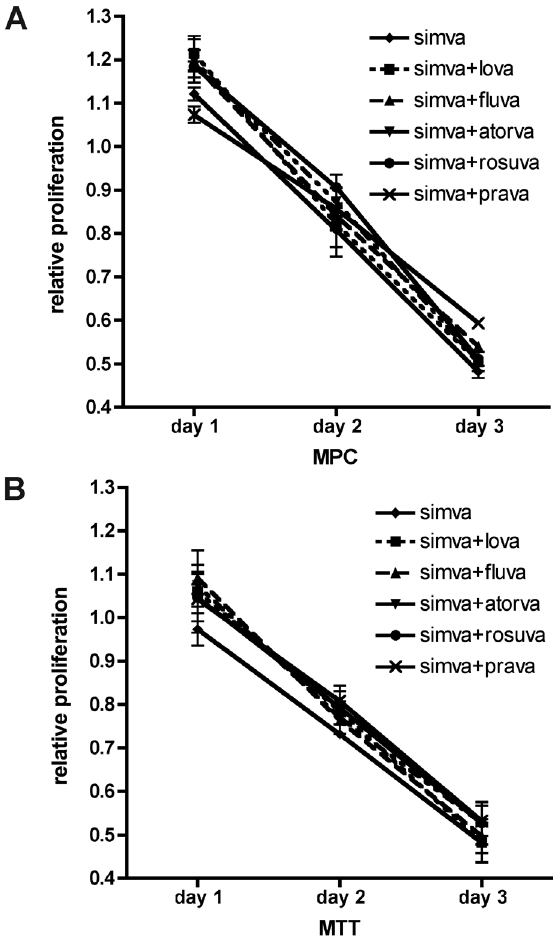
Figure 4. Combination of two different statins to evaluate potential additive effects on MPC or MTT. Relative viability of MPC (A) and MTT (B) at the indicated doses and durations for the most effective combined treatments including simvastatin relative to simvastatin alone.